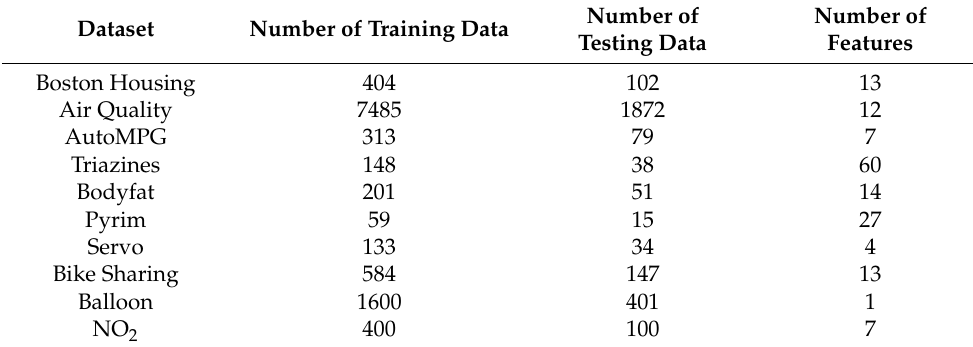
Table 3. Description of benchmark